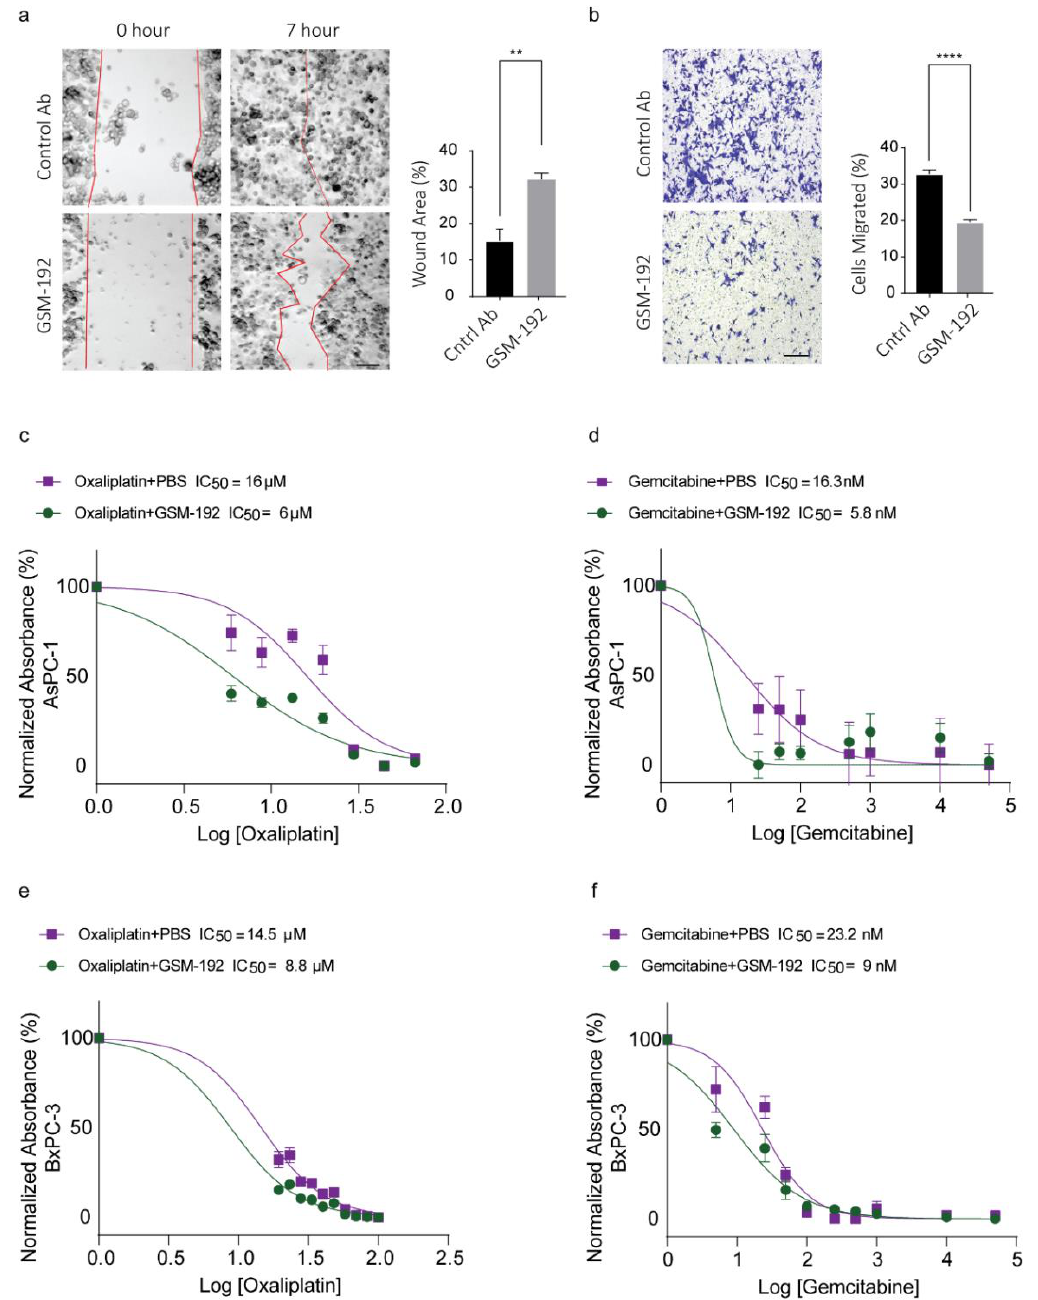
Figure 4. GSM-192 treatment reduces and retards cell migration and potentiates cells to chemotherapy. ( a ) Treatment with GSM-192 slowed down cell migration in a standard scratch assay. Six hours post treatment; control antibody treated wells close the scratch/wound, but not the GSM-192 treated wells. Data represent mean values ± s.e.m, and significance was evaluated with a two-tailed t -test. ** p ≤ 0.01, Scale bar, 20 µ m. ( b ) GSM-192 reduces cells migrating across the transwell membrane significantly 15 h post treatment. Data represent mean values ± s.e.m., and significance was evaluated with a two-tailed t -test. **** p ≤ 0.0001 Scale bar, 20 µ m. ( c – f ) MTT cell death assay absorbance data plotted as a function of the log of Gemcitabine (GEM) concentration and fitted on a variable slope sigmoidal regression model show markedly reduced IC 50 of GEM/OX+GSM-192 group compared to the GEM/OX+PBS group in AsPC-1 ( c , d ) and BxPC-3 ( e , f ). Data from one out of three representative experiments are